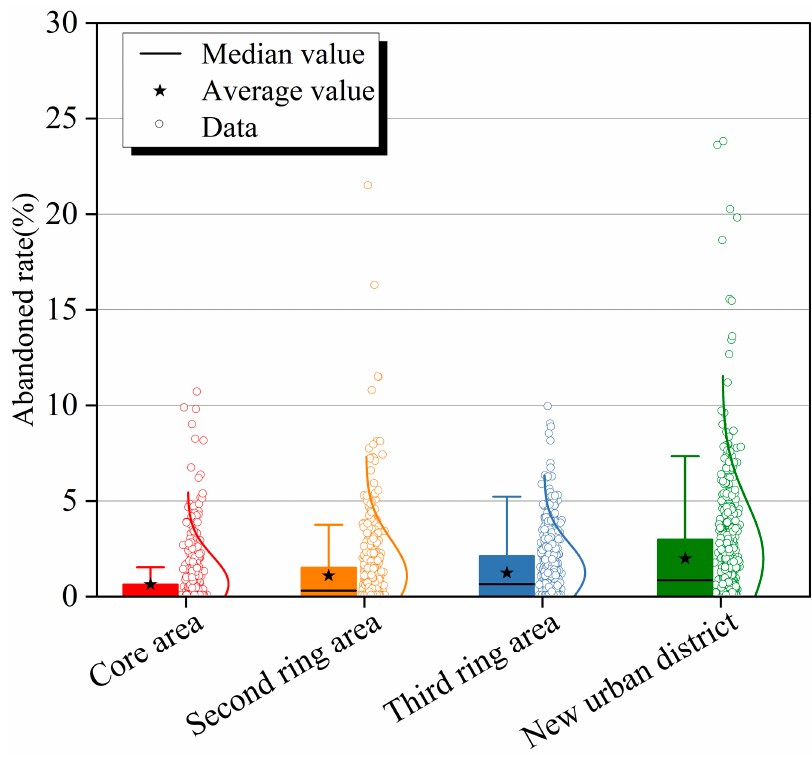
Figure 3. Boxplot of abandonment rate in Kunming’s Main Urban District.